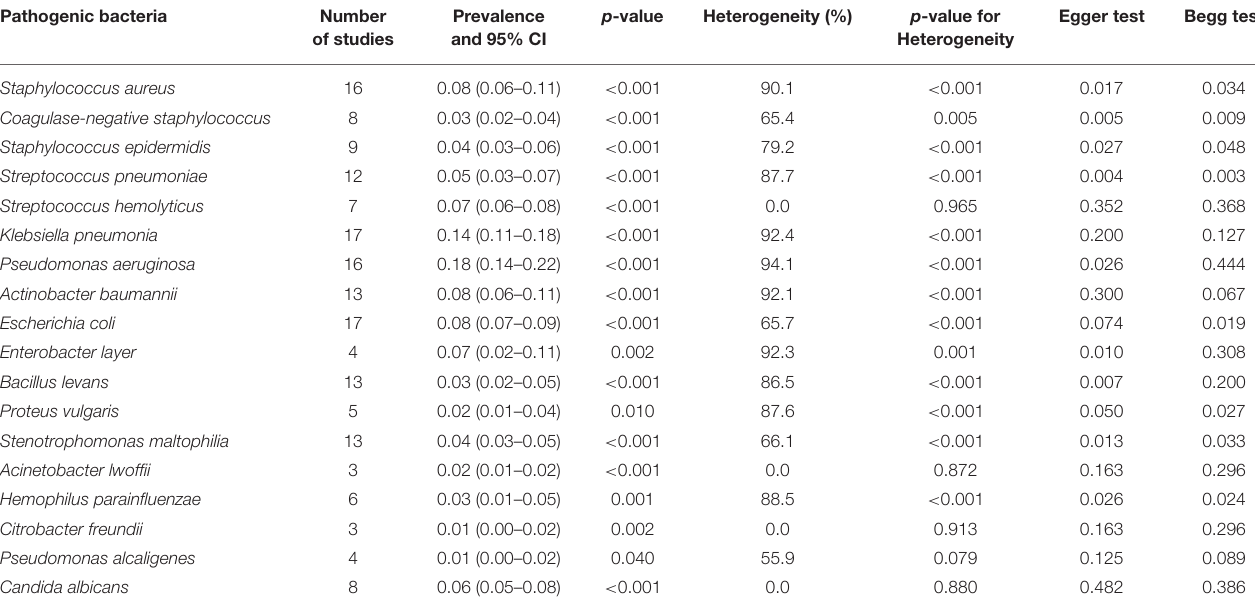
TABLE 1 | Summary results for specific pathogenic